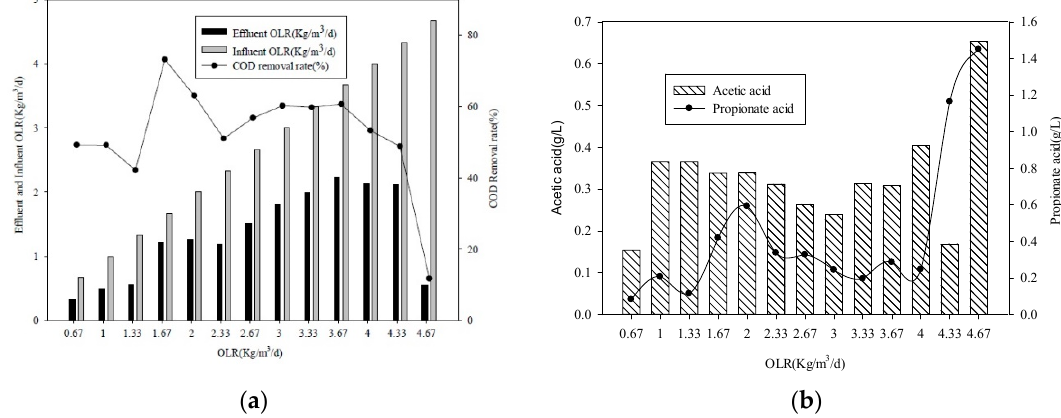
Figure 3. Influent and effluent chemical oxygen demand (COD) and COD removal rate ( a ) and volatile fatty acid (VFA) content ( b ) with OLR throughout the operation time.